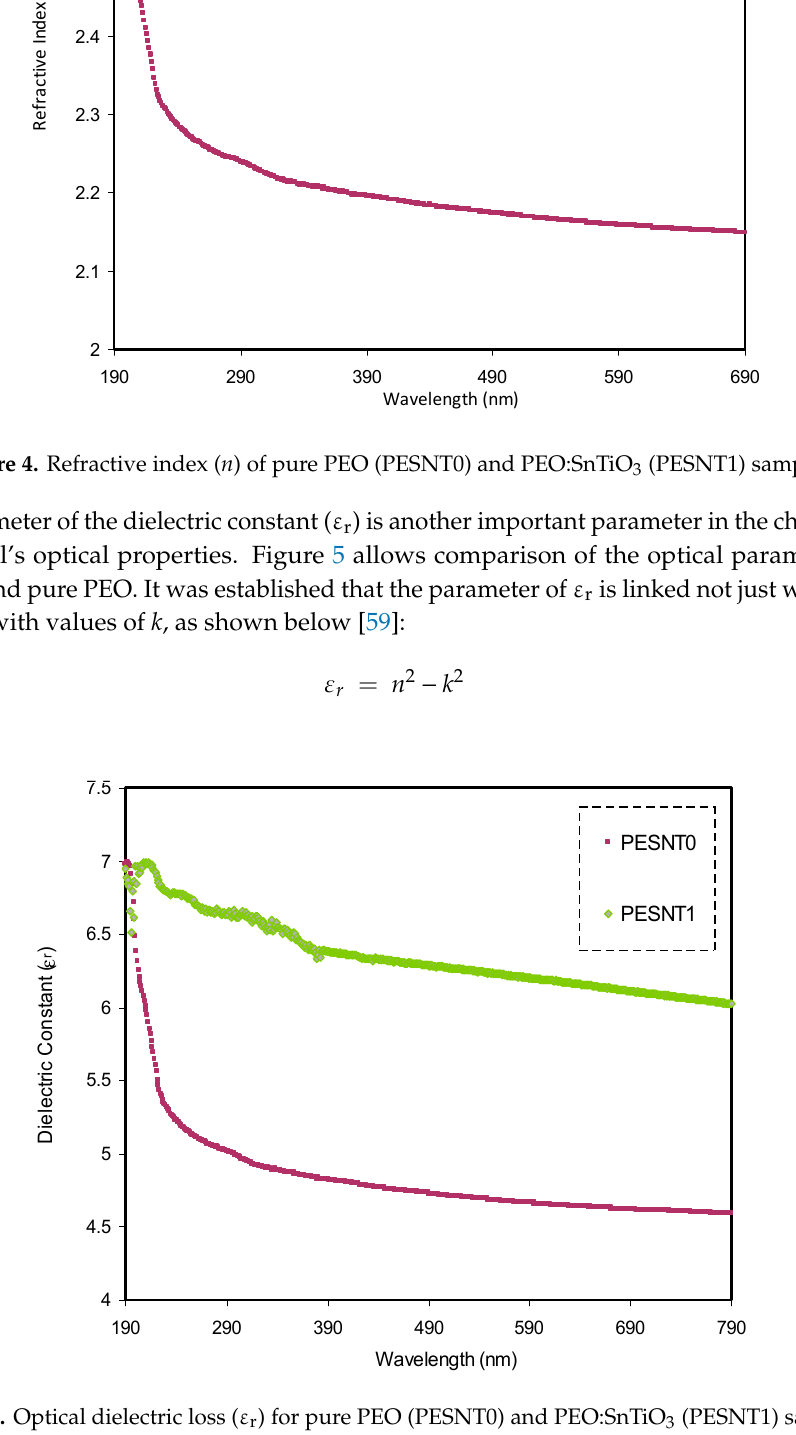
Figure 5. Optical dielectric loss ( ε r ) for pure PEO (PESNT0) and PEO:SnTiO 3 (PESNT1) samples.